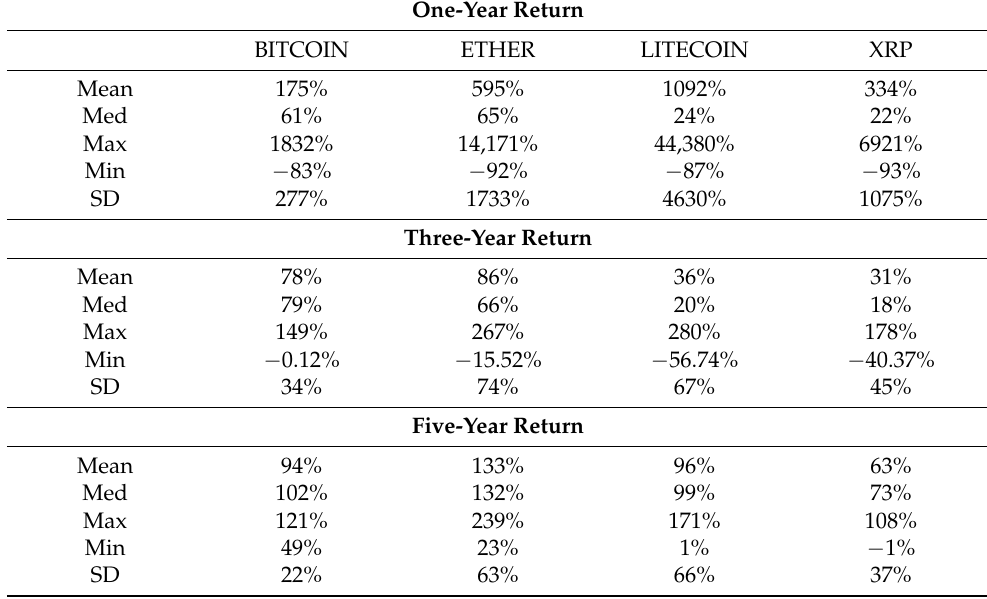
Table 4. Holding Period Performance.